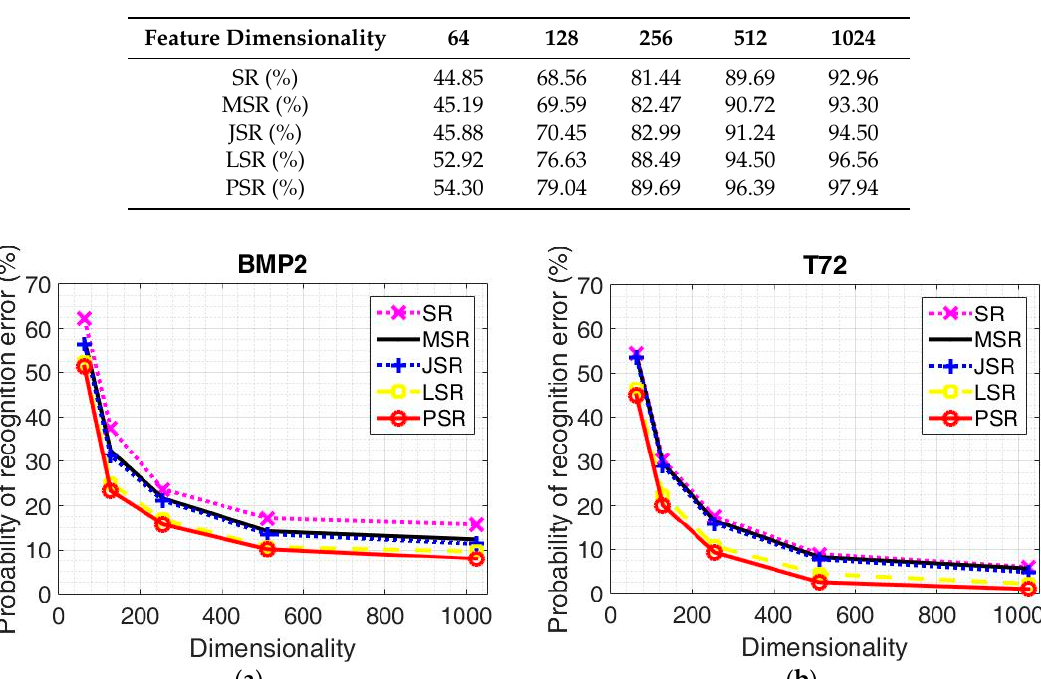
Table 5. The recognition results for configurations of T72.